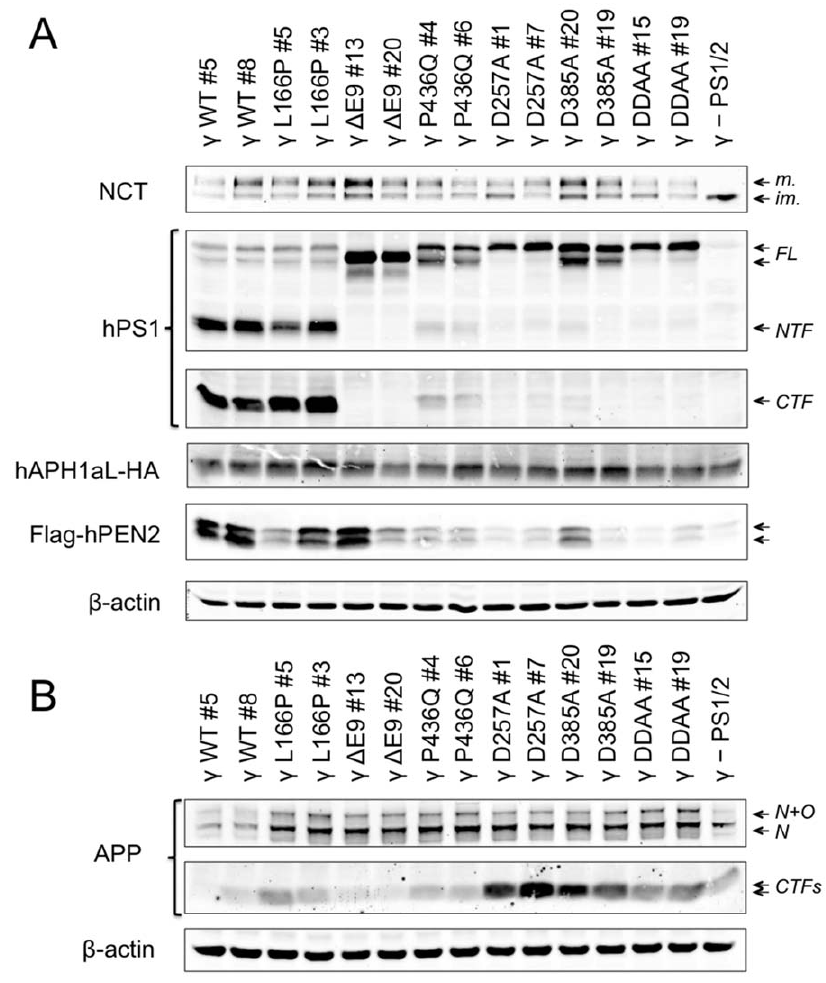
Figure 1. Generation of stable cell lines overexpressing all human c -secretase components with FAD-linked PS1 variants. MEF PS1/ 2 2 / 2 were stably co-transduced with lentiviral vectors carrying genes encoding hNCT-V5, Flag-hPEN2, hAPH1aL-HA and clones were isolated by limiting dilution to generate a cell line, designated as c - PS1/2, that overexpresses high amount of the three subunits. c - PS1/2 MEFs were further transduced with hPS1 variants harbouring FAD-linked mutations or mutations in the catalytic aspartate residue(s), or PS1-WT, and cloned. Each clone, derived form the c - PS1/2, was conveniently named according to the mutation present in PS1 preceded by the symbol c and followed by the number of the clone ( c -MEF) in order to distinguish them from wild-type MEF (WT MEF) and MEF PS1/2 2 / 2 . Two clones per c -secretase variant were selected for characterization. (A–B) Whole cell protein extracts of the different cell lines were prepared in 1% NP40-HEPES buffer, separated by SDS-PAGE on 4– 12% Bis-Tris or 12% Tris-Glycine gels and analysed by immunostaining to detect the c -secretase core components NCT (NCT164), PS1 (NTF, MAB1563; CTF; MAB5232), APH1aL-HA (3F10), and Flag-PEN2 (M2) (A), and endogenous APP (A8717) (B). b -Actin was used as a loading control. Each lane represents one selected clone. CTF : C-terminal fragment, FL : full-length, im. : immature NCT; m. : mature NCT, N : N-glycosylated, NTF : N-terminal fragment, O : O-glycosylated. doi:10.1371/journal.pone.0035133.g001 A b 1–40 and A b 1–42 levels was observed in the cell culture media of cell lines overexpressing human c -secretase ( c -MEF WT), in comparison to untransduced WT MEFs (Figure 2B). Also, the average A b 1–42/A b 1–40 ratios were not significantly different in those cell lines (Mean 6 SD: c -MEF WT # 5: 0.30 6 0.01; c -MEF WT # 8: 0.29 6 0.01; WT MEF: 0.19 6 0.06). Next, overexpression of SPA4CT-Flag in c -MEFs led to the pronounced intracellular accumulation of APP-CTFs in cells overexpressing the PS1 aspartate mutants (Figure 2C), and to the secretion in the cell culture media of different A b levels as measured by ELISA (Figure 2D). First, only traces of both A b 1–40 and A b 1–42 were detected in c -MEFs overexpressing PS1 with aspartate mutants. Next, c -MEFs overexpressing PS1 with FAD-linked mutations displayed a pronounced variability in A b levels when compared to